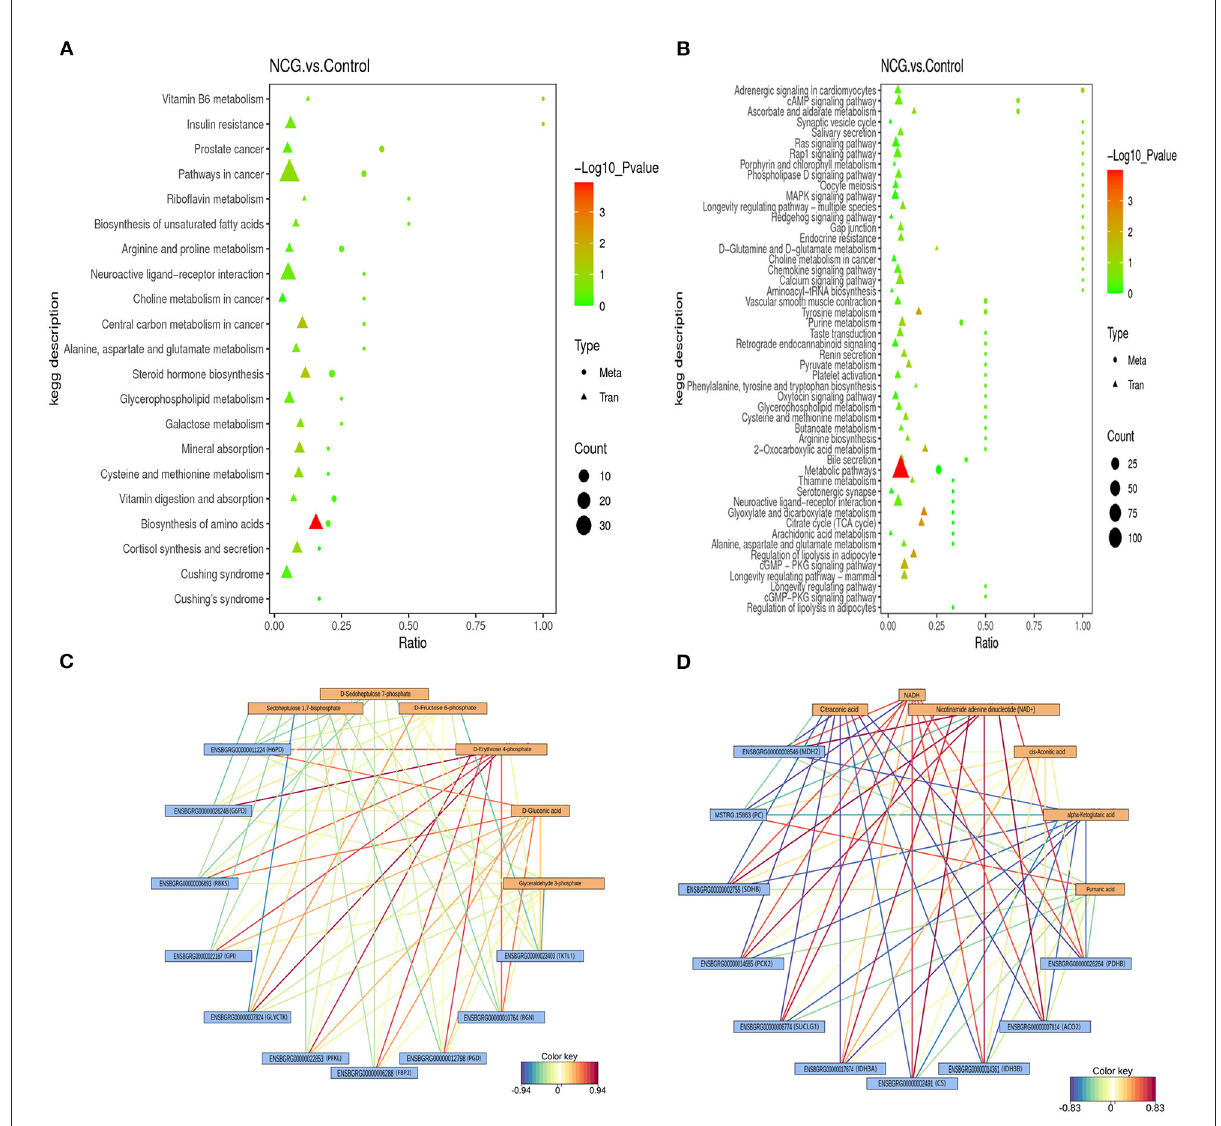
FIGURE6 Integrated altered metabolic pathways identified based on the transcriptomic and metabolomic data. The vertical axis presents the pathway description under the positive (A) and negative (B) ion modes, and the horizontal axis presents the ratio of the DEGs and DMs. Correlation network corresponding to DEG- and MD-enriched pathways associated with the pentose phosphate pathway (C) and TCA cycle (D)